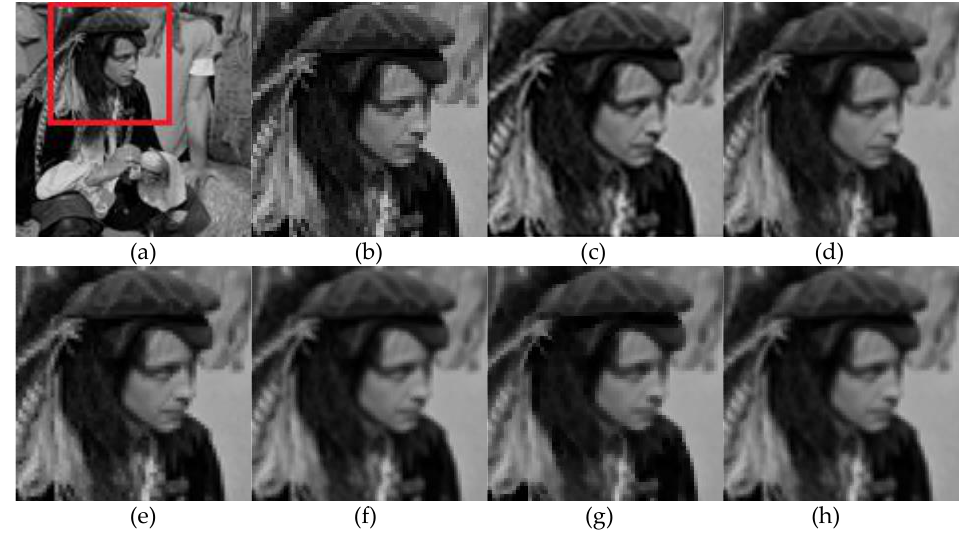
Figure 14. (a) Man test image inside a red square: (b) traditional nearest neighbor (TN), (c) 388 Figure 14. ( a ) Man test image inside a red square: ( b ) traditional nearest neighbor (TN), ( c ) traditional